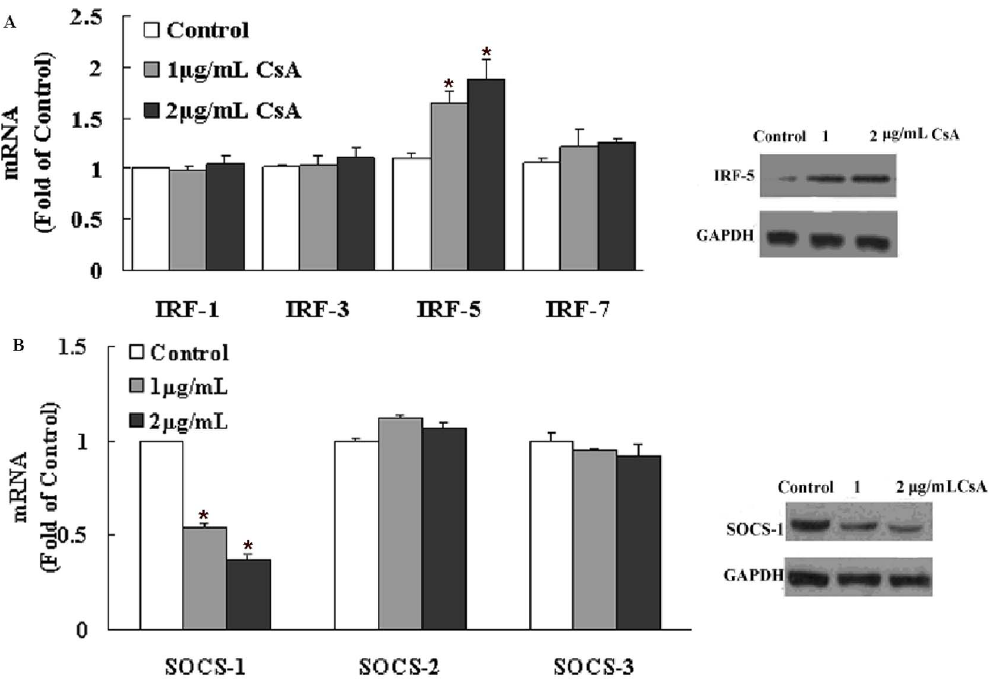
Figure 4. Effect of cyclosporin A (CsA) on the expression of the type I interferon (IFN) signaling pathway regulators. Wa rotavirus- infected HT-29 cells were treated with CsA at indicated concentrations at 12 h post-infection. Total cell lysates were collected at 24 h post-treatment. (A) Interferon regulatory factor (IRF)-1, -3, -5, and -7 mRNA levels were analyzed by real-time PCR, and protein levels were measured by western blotting. GAPDH was used as an internal control for RT-PCR and a loading control for western blotting. (B) Suppressor of cytokine signaling (SOCS)-1, - 2, and -3 mRNA levels were analyzed by real-time PCR, and protein levels were measured by western blotting. GAPDH was used as an internal control for RT-PCR and a loading control for western blotting. Data are expressed as mRNA levels relative (fold) to the control (without CsA treatment, which is defined as 1). Data shown are expressed as mean 6 standard deviation of triplicate culture, and 3 independent experiments were carried out (* P ,